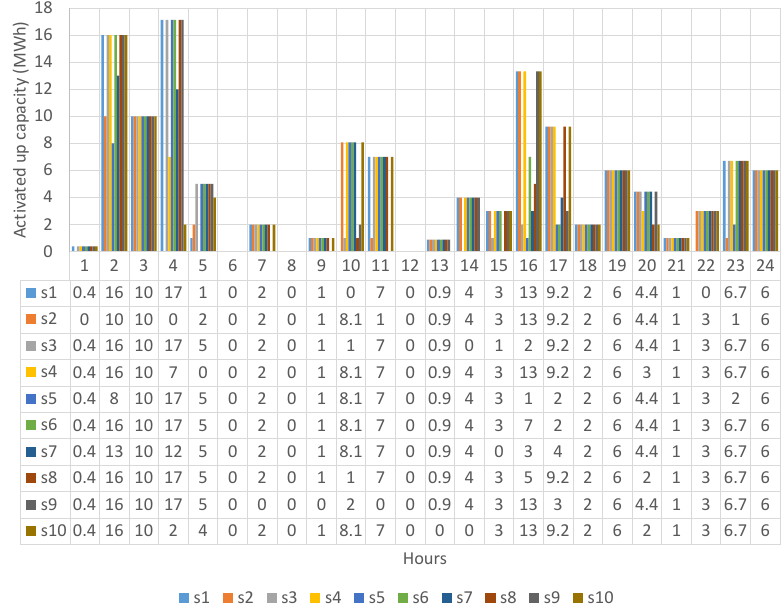
Figure 8. Activation of the battery storage up reserve ( q a ↑